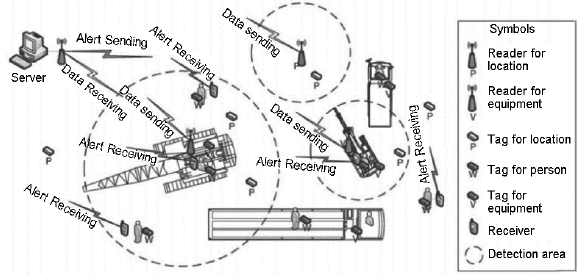
Fig. 3. Location of tags and divided excavation area (Chae, Yoshida